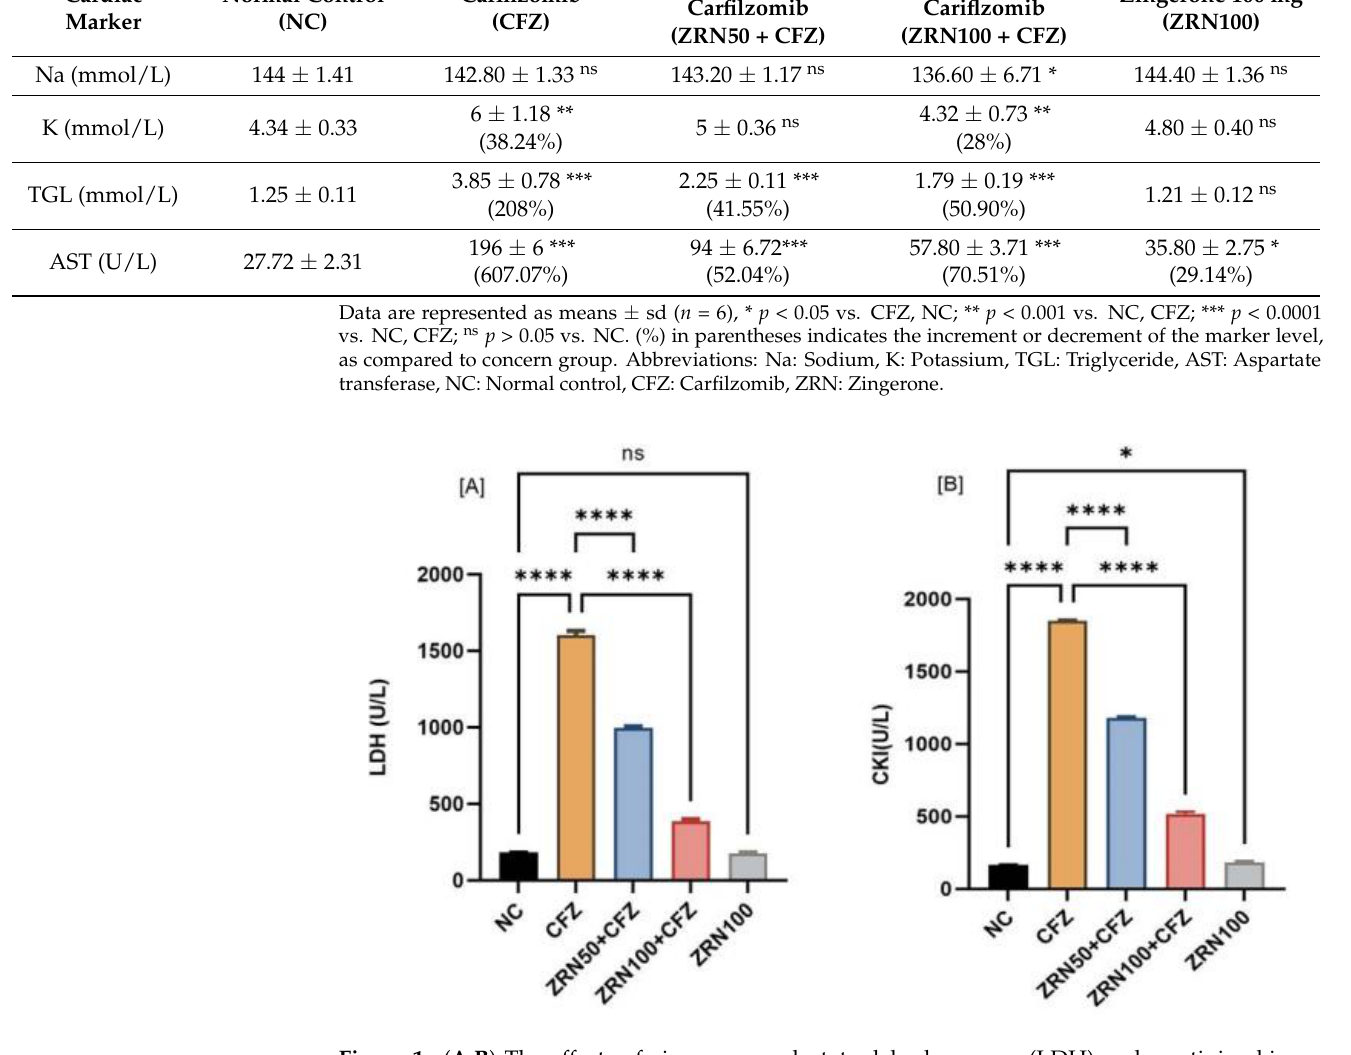
control group. The treatment with zingerone significantly reduced the IL-1 β and IL-6, as compared to the carfilzomib-treated group. It was also noticed that carfilzomib adminis- tration significantly increased in tumor necrosis factor TNF α and caspase-3. Pretreatment with zingerone reversed these levels of TNF α and caspase-3. Pretreatment with zingerone alone had no discernible differences from normal controls (Figure